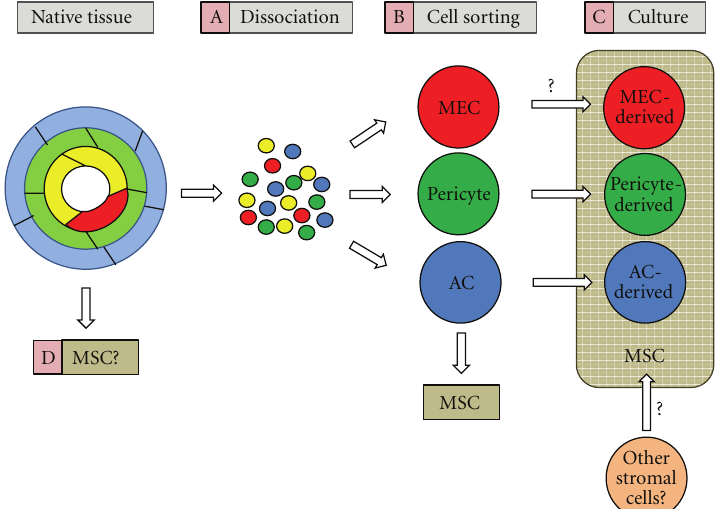
Figure 2: Schematic depiction of hBVSCs at the origin of mesenchymal stem/stromal cells (MSCs). (A) hBVSCs, including myogenic endothelial cells (MECs, red), pericytes (green), and adventitial cells (AC, blue), are dissociated from fresh muscle biopsy and separated from endothelial cells (yellow) and other cell types. (B) Dissociated cells are purified to homogeneity by fluorescence-activated cell sorting (FACS) and newly sorted MECs, pericytes, and ACs already exhibit multilineage developmental potentials. (C) FACS-purified pericytes, ACs, and possibly MECs give rise to authentic MSCs in long-term culture. (D) Nevertheless, whether native hBVSCs serve as a source of MSCs in situ and participate in tissue repair and regeneration remains an open